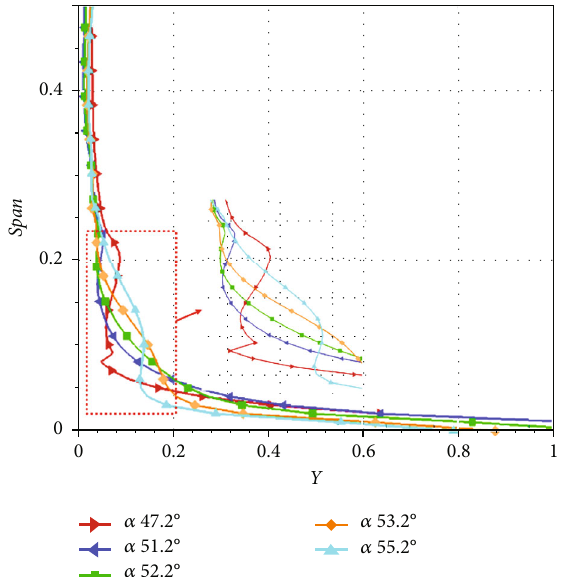
Figure 8: Comparison of total pressure loss coe ffi cient for di ff erent stagger angles.